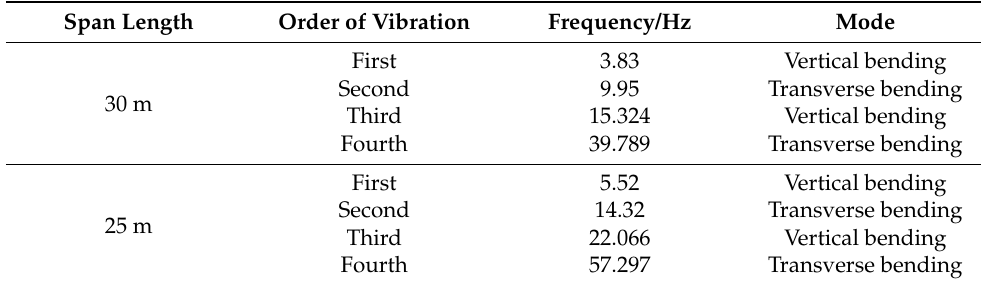
Table 2. Natural vibration characteristics of bridge.